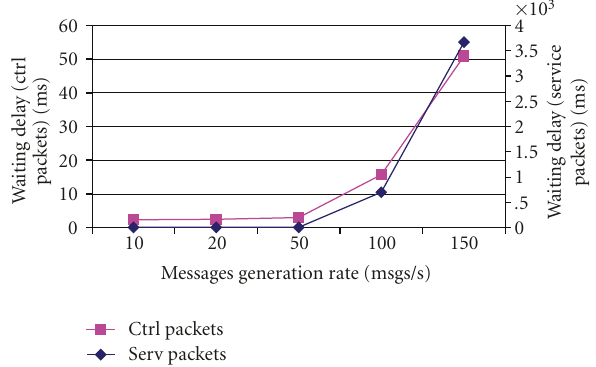
Figure 11: Delay versus Messages Generation Rate (mean message size = 500 bytes and mean number of neighbors = 50).